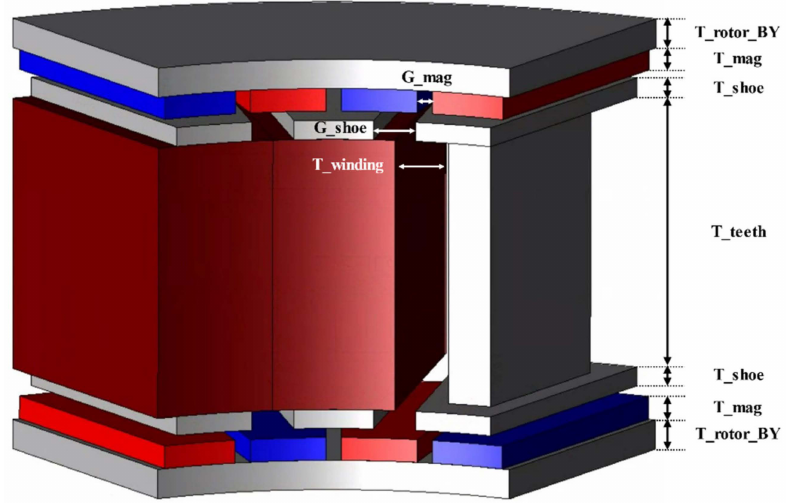
Figure 15. Design variables of the DRAFPM motor.